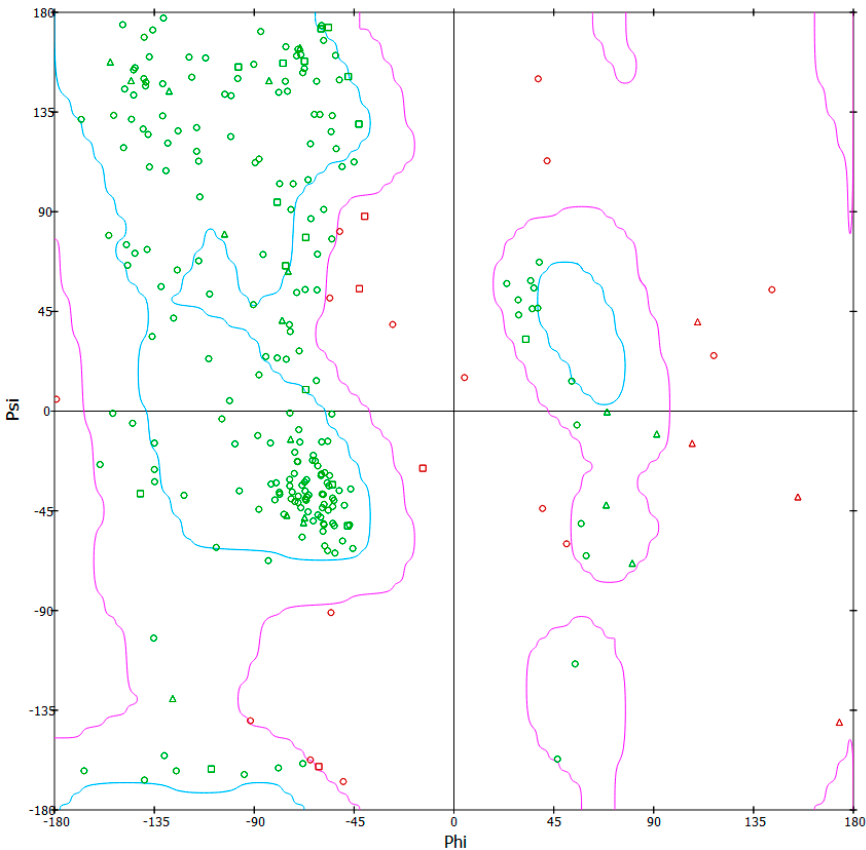
Figure 2. BIOVIA result for modeled PR-1-like Protein (Fpr1) of Fusarium oxysporum using the generated model from I-TASSER. Residues in most favored regions (upper first box on the left), residues in additional allowed regions (lower box on the left), and residues in generously allowed regions (upper box on the right). Table 4. Physicochemical properties of the anti- Fusarium oxysporum AMPs.